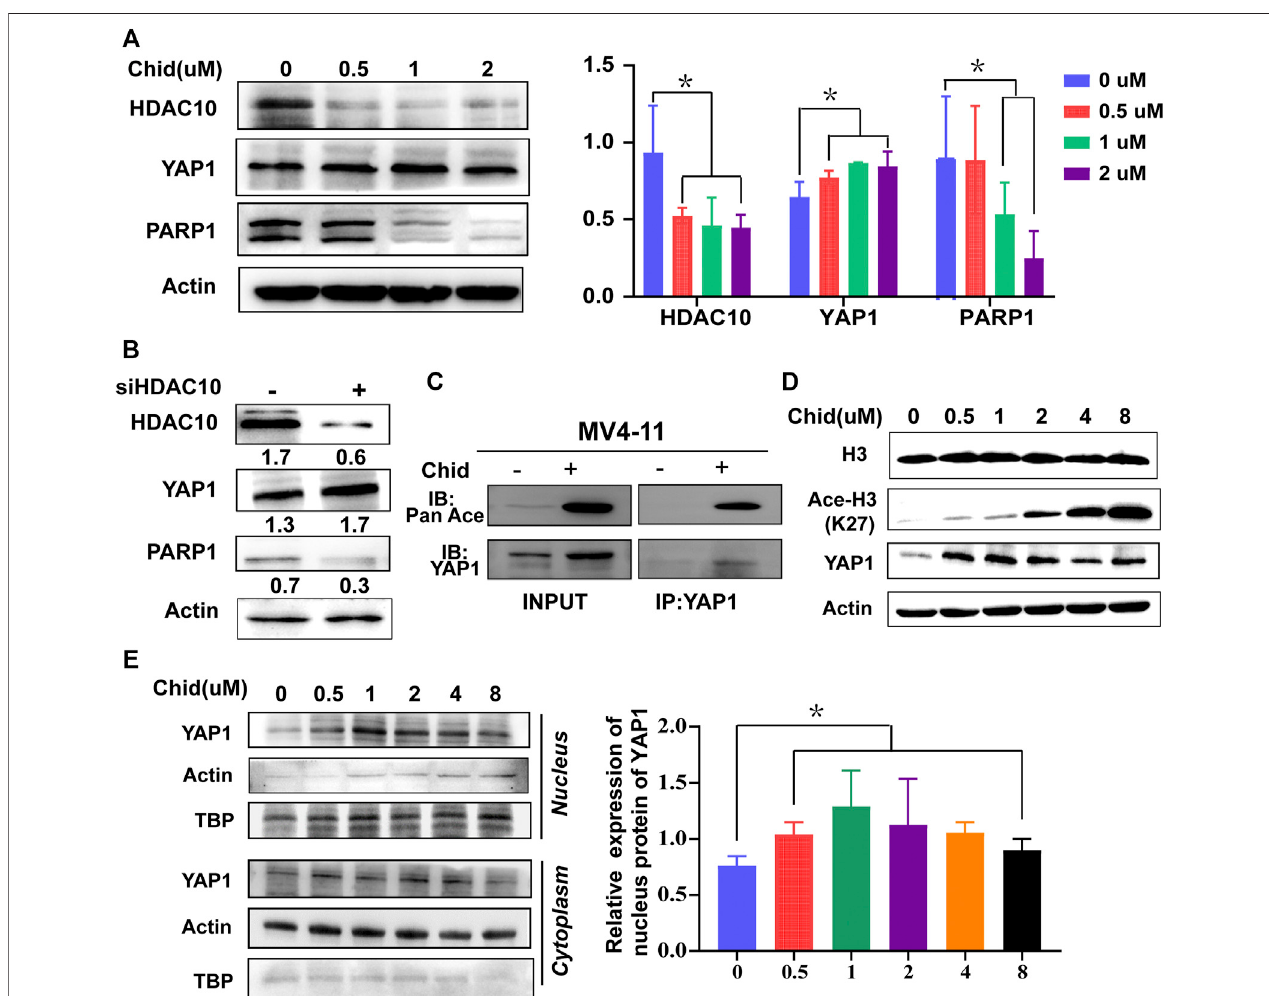
FIGURE5| AcetylationlevelofYAP1wasenhancedbyHDAC10knockdownthroughH3K27acetylation,accompaniedwiththeincreasednuclearaccumulationof YAP1andthedecreasedexpressionofPARP1. (A) ExpressionlevelsofHDAC10,YAP1,andPARP1wereanalyzedbyWesternblotinMV4-11cellsaftertreatmentwith chidamide (0, 0.5, 1, 2 μ M) for 24 h. (B) Expression levels of HDAC10, YAP1, and PARP1 were analyzed by Western blot in YAP1 knockdown (si-YAP1) and non- silencing scrambled control (si-Con) MV4-11 cells. (C) Acetylation level of YAP1 was assessed by co-immunoprecipitation assay in chidamide-treated